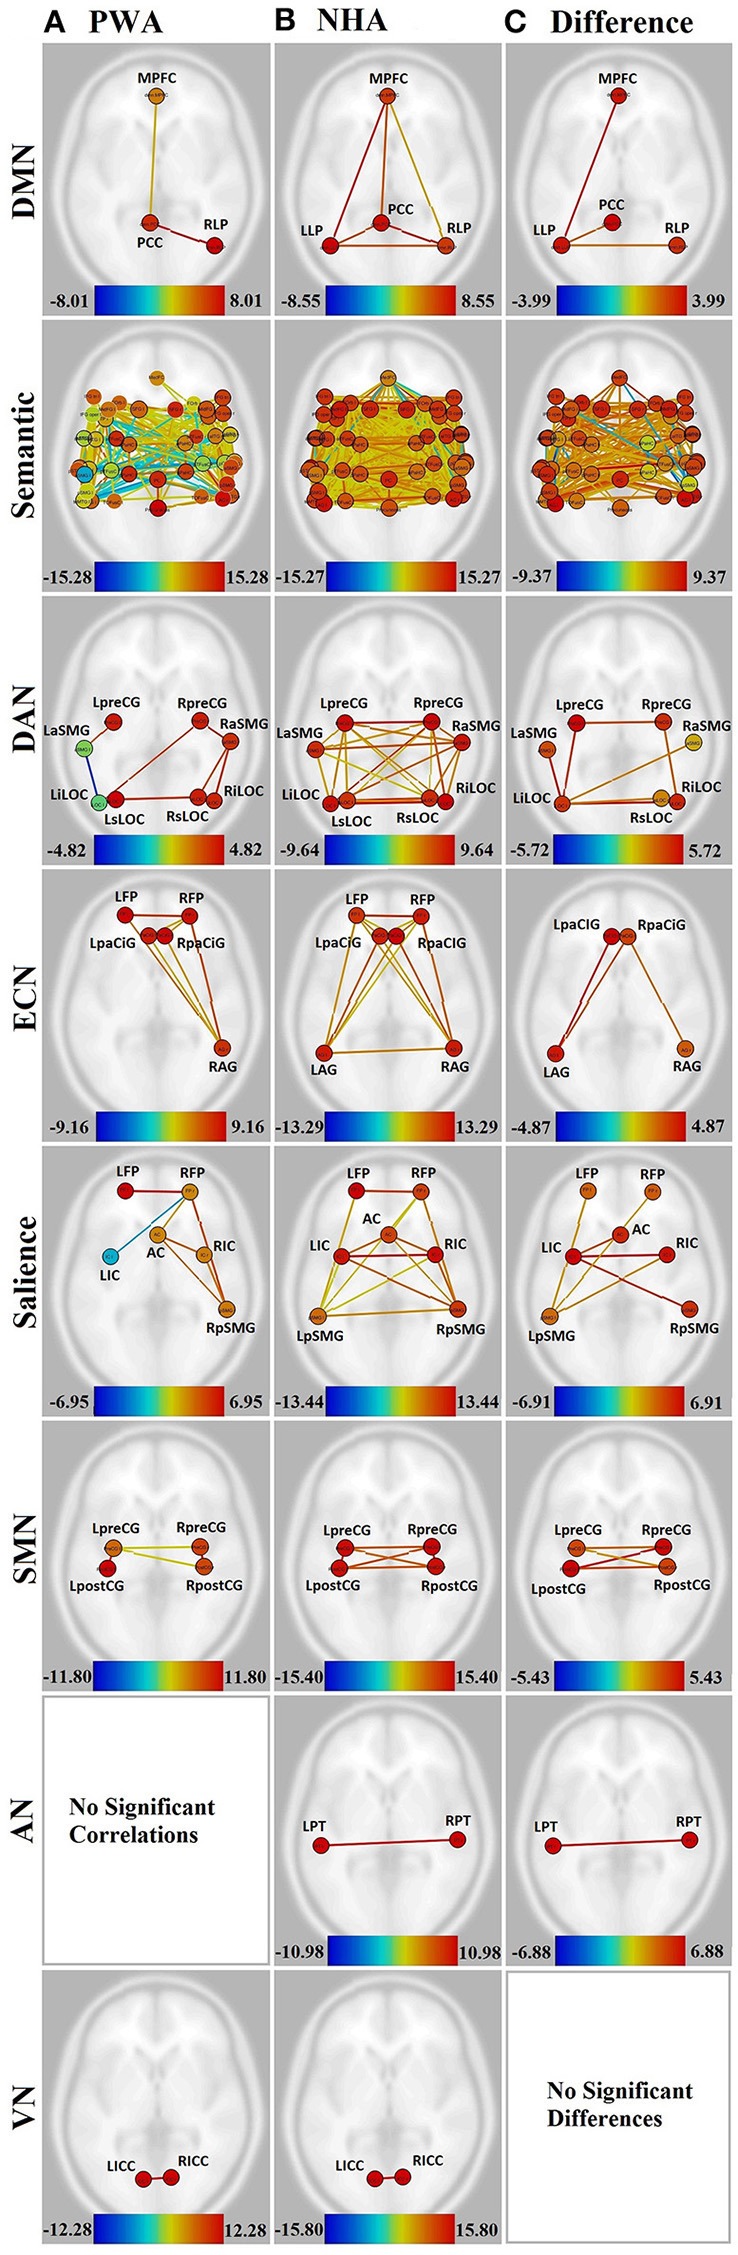
Visualization of all networks probed across groups and contrasts. Figures presented following neurological convention with left visualized on the left. (A) Persons with aphasia (PWA); (B) Neurologically healthy adults (NHA); (C) Difference in connectivity between groups. For (A,B), warm colors represent statistically significant positive correlations, cool colors represent statistically significant negative correlations (anticorrelations). For (C), warm colors represent statistically greater correlations for NHA, cool colors represent statistically greater correlations for PWA. See Supplementary Tables 1, 2 for exact T-values and FDR p-values.